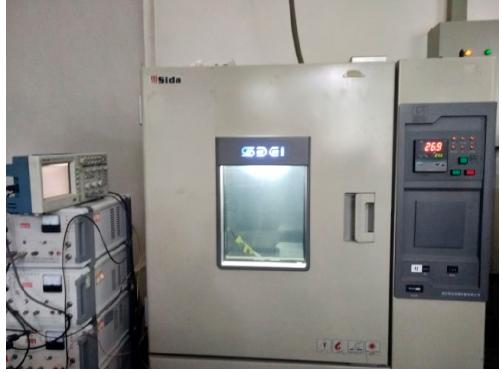
Figure 3. The thermostat for RLG temperature experiments.